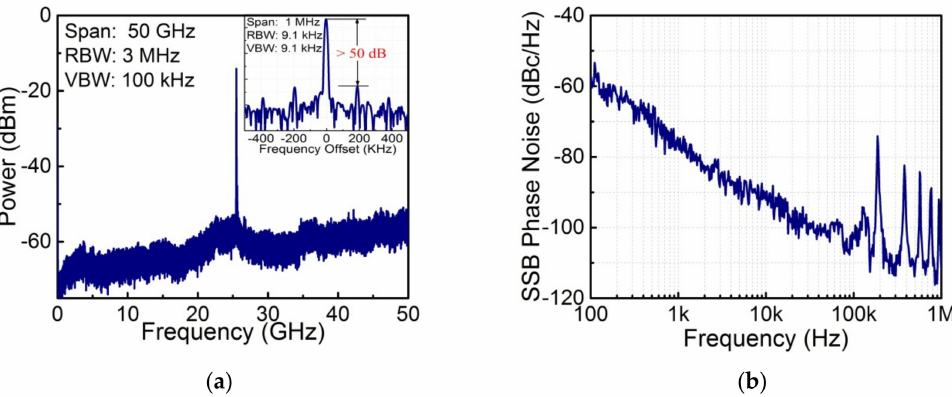
Figure 5. ( a ) The RF output from the OEO, Inset: zoom-in view in a frequency range of 1 MHz; ( b ) single sideband (SSB) phase noise spectrum of the generated 26.05 GHz microwave